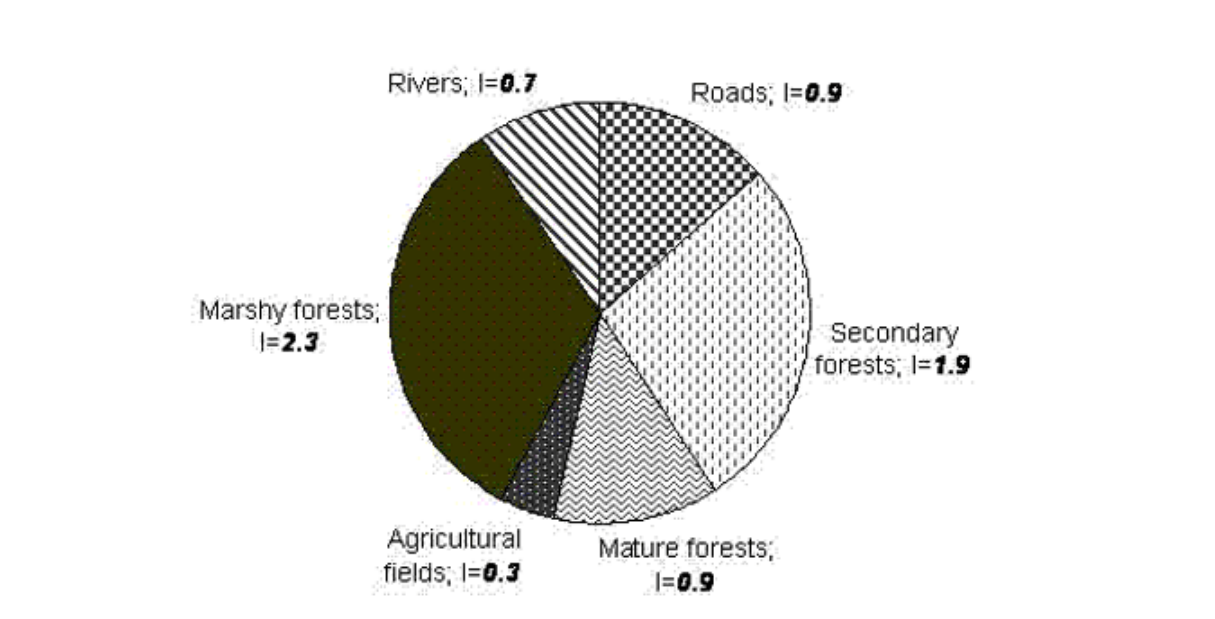
Fig. 3. Index of hunting pressure (I) in each habitat type in Ntsieté hunting